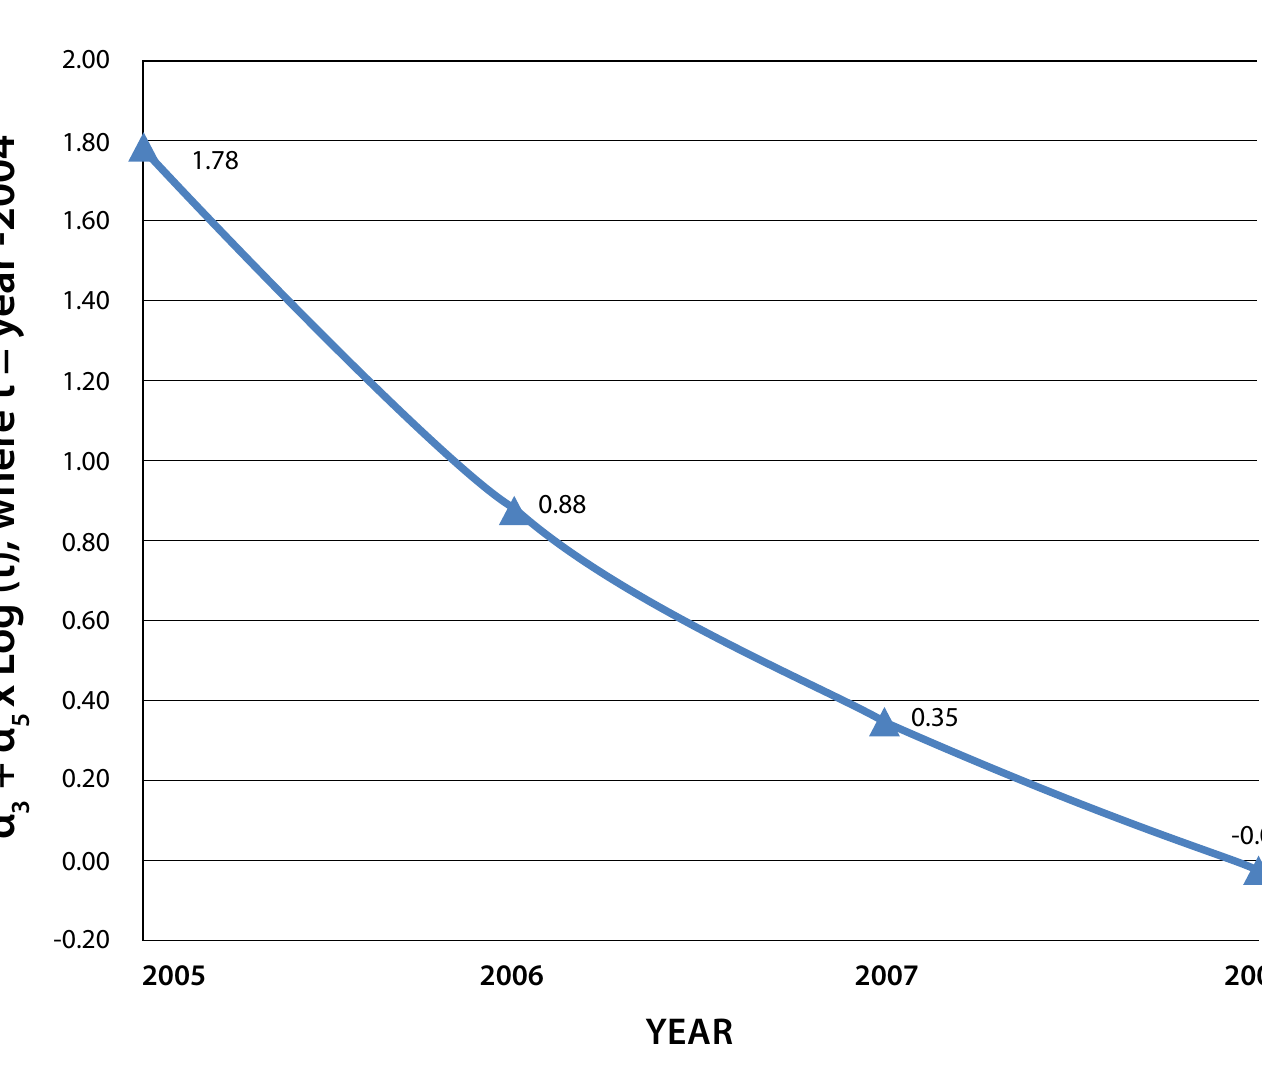
Figure 2. Diminishing effect of innovativeness on a value